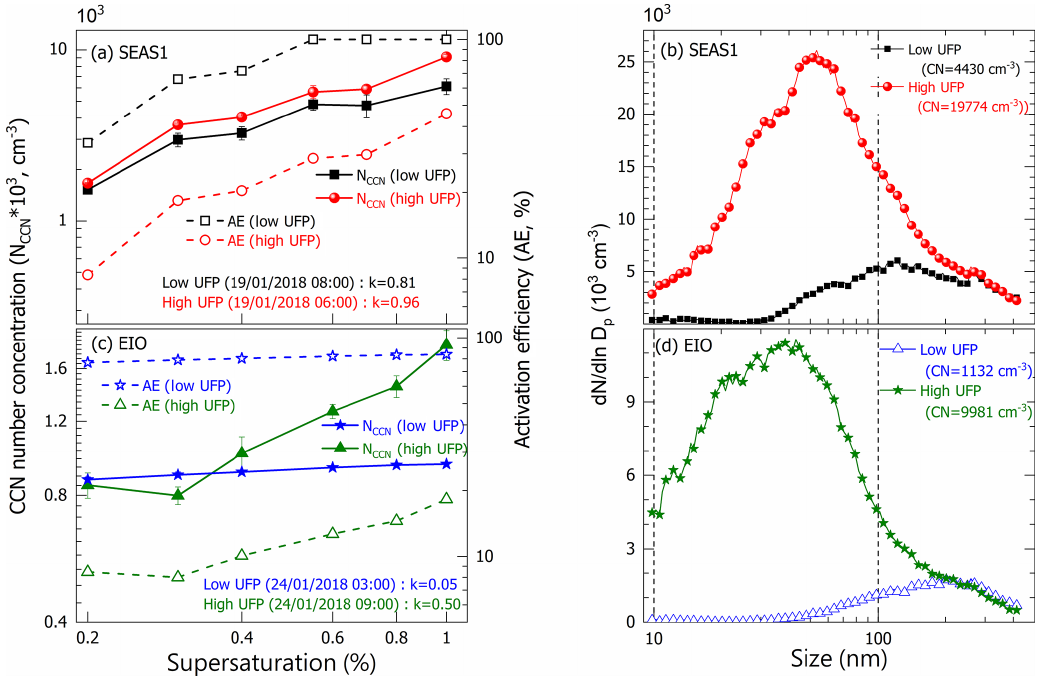
Figure 7. (a, c) Typical cases of supersaturation spectra of CCN number concentration and activation efficiency (AE) for high and low concentration of ultrafine particles (UFP) over SEAS1 and EIO. (b, d) The aerosol number size distributions corresponding to (a) and (c)